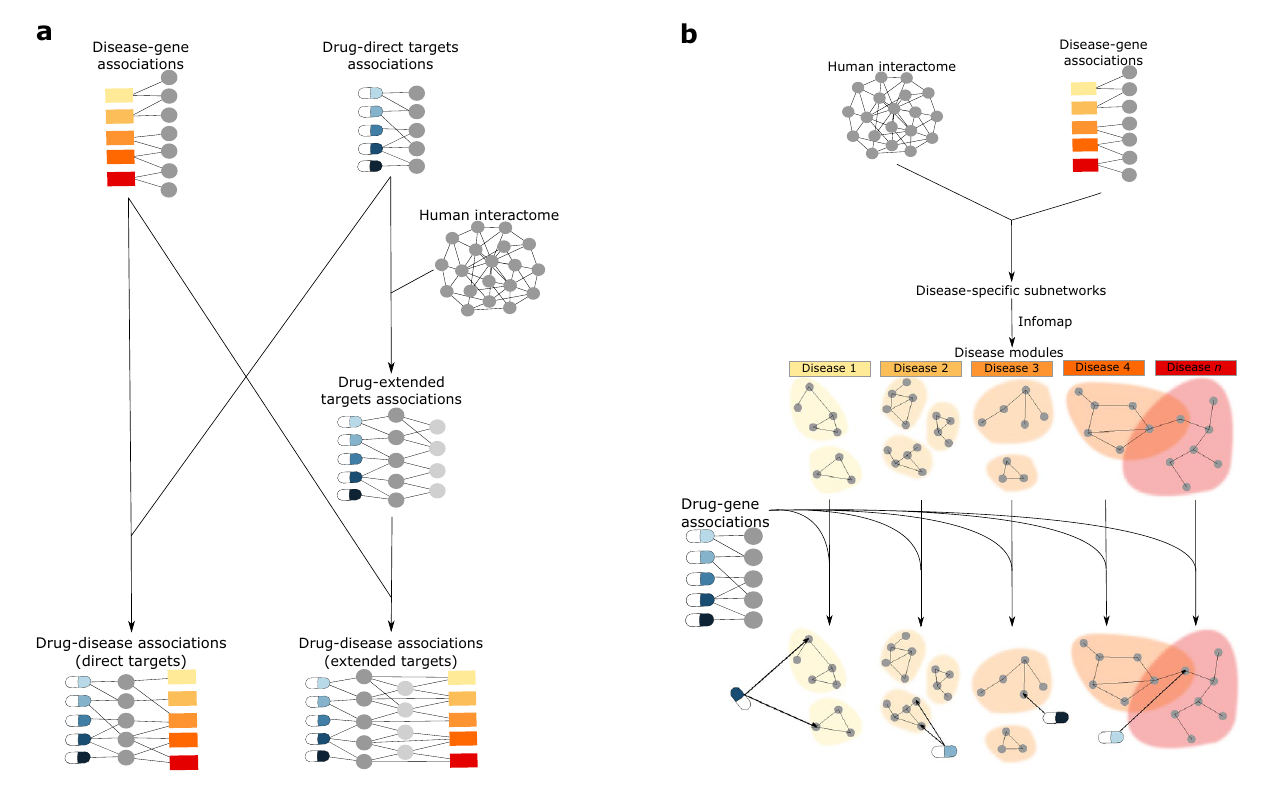
Figure 1. Schematic overview of study workflow. ( a ) The human interactome (FunCoup 38 ) was used to map drug target associations for FDA-approved drugs from DrugBank 40 and disease-gene associations from DisGeNET 42 . The sets of drug targets were also extended using first order neighbors in the human interactome. The overlap between drug targets and disease gene sets was analyzed to determine the potential disease leverage that could be offered by repurposing. ( b ) In order to find disease modules, the interactions between disease genes retrieved from the human interactome were partitioned using Infomap 47 . The overlap between drug targets and disease genes was later analyzed to map drugs to the disease